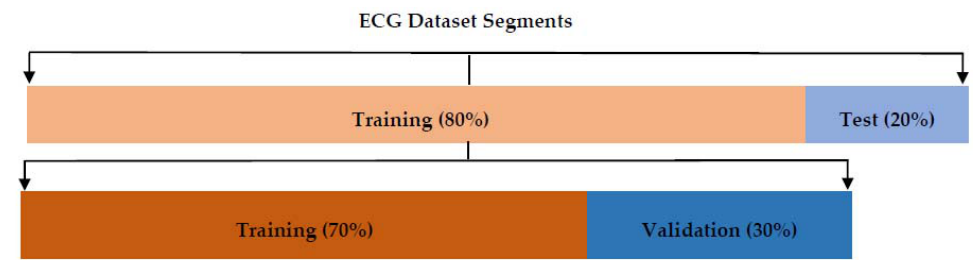
Figure 5. The distribution of ECG segments used for training and testing. Eighty percent of the data was used for training and 20% was used for testing. Thirty percent of the training dataset was used for validation of the network.